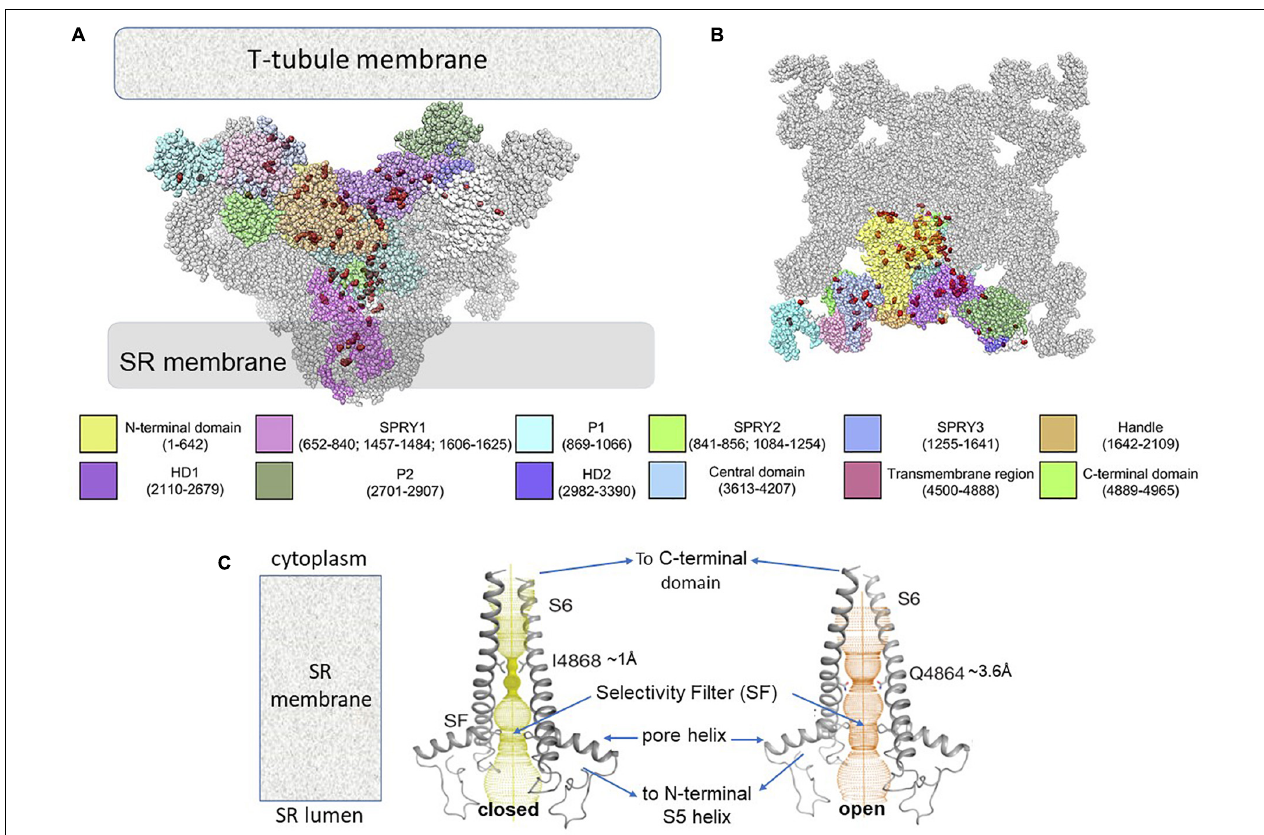
FIGURE 1 | Distribution on RyR2 structure of gain-of-function RyR2 CPVT mutations and changes in RyR2 pore with channel opening, likely to characterize the pore with CPVT. (A) A side view of RyR2 as viewed in its location between the transverse (T) – tubule and SR membranes. Three of the four RyR monomers forming the tetrameric channel are shown, with the various domains of the central monomer are color coded. The fourth monomer is hidden behind the three monomers. (B) A cytosolic section through the tetramer perpendicular to the view in (A) and parallel to the T-tubule membrane. In (A,B) , 108 human gain-of-function mutations (Priori et al., 2021) are shown as red spheres. Color codes for domains in (a) and (b) are given along with residue numbers. HD – helical domain. The figure has been modified from Figure 4 (Priori et al., 2021) under copyright License #5194490720614. Labeling only has been modified. (C) The pore is shown traversing the SR membrane. In the closed conformation (left) the pore is constricted to ∼ 1 Å at I4868. In the open conformation the constriction expands to ∼ 3.6 Å with the minimum at Q4864. There is a second constriction at the selectivity filter (SF) near the junction of the pore helix and S6 helix which is similar in the open and closed state. On the luminal side of the pore the N-terminus of S6 is continuous with the pore helix and then the S5 helix which connects to the reminder of the transmembrane domain and the cytoplasmic central domain. The cytoplasmic C-terminal end of S6 is continuous with the C-terminal domain which shares interdomain interactions with central domain as indicated in the figure. The Figure has been modified from Figure 3 (Gong et al., 2019) under copyright License # 5194601053471. Labeling only has been